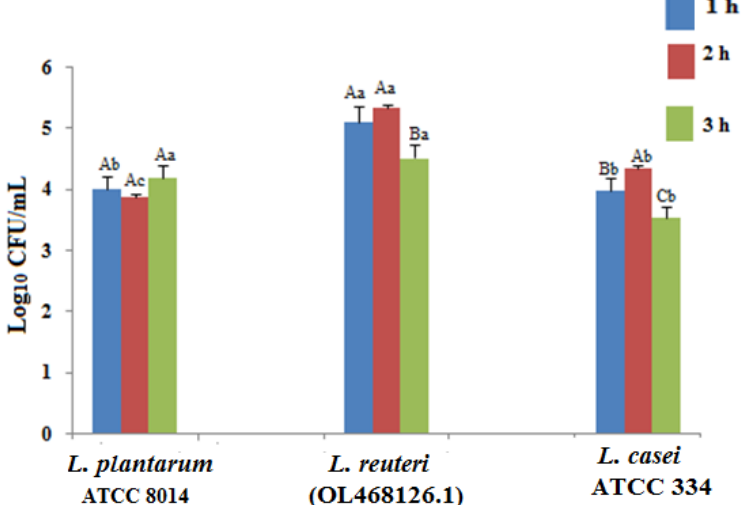
Figure 1. Tolerance of the isolated Limosilactobacillus reuteri (OL468126.1), Lactiplantibacillus planta- rum ATCC 8014, and Lacticaseibacillus casei ATCC 334 to pH = 2 ( A ), pH = 3 ( B ), and pH = 5.8 ( C ) after 1, 2, and 3 h of incubation. Data are the mean values of three replicates, and the error bars indicate the standard deviation ( n = 3). Capital letters are used to indicate the significant differences observed for the same strain after different periods (1, 2, and 3 h). Different small letters indicate significant differences between the strains in the same condition ( p < 0.05).